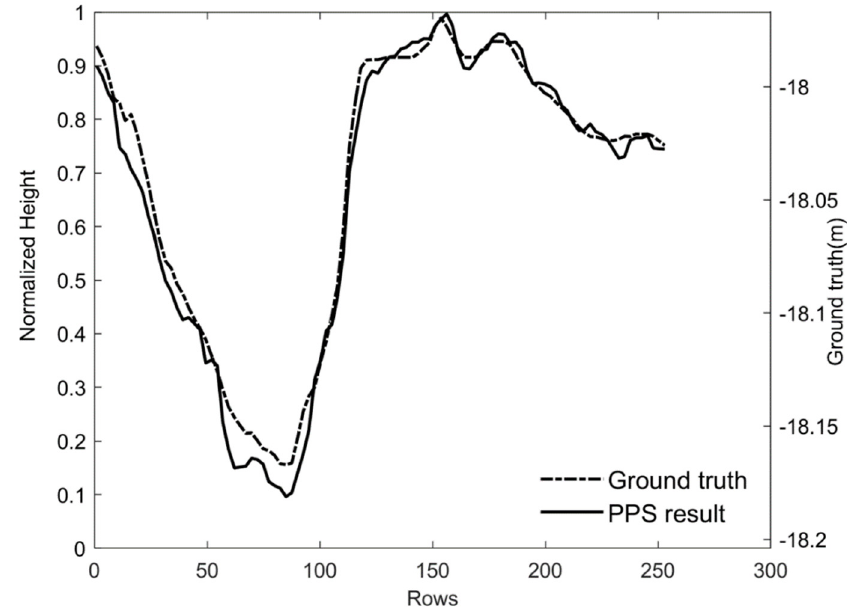
Figure 8. Height profile of ROI 1 in simulated imagery.